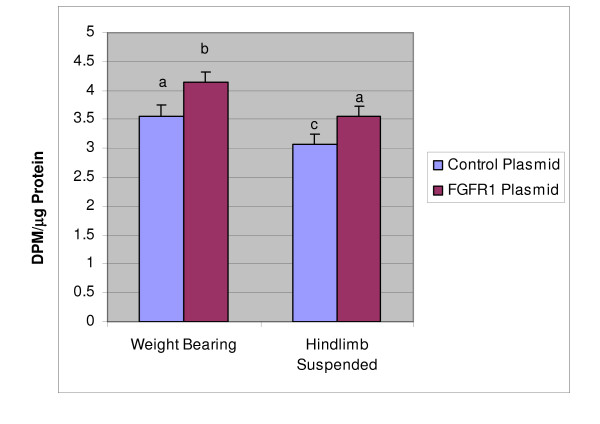
Overexpression of skeletal muscle with FGFR1 increases protein synthesis. Incorporation of L-[4-3H] phenylalanine in gastrocnemius and soleus muscles of weight bearing or hindlimb suspended mice transfected with control (control) or FGFR1 expression plasmid DNA (FGFR1). Values represent back transformation of means (+SE/-SE) generated using a square root transformation. Values bearing different letters differ significantly (P < 0.05).